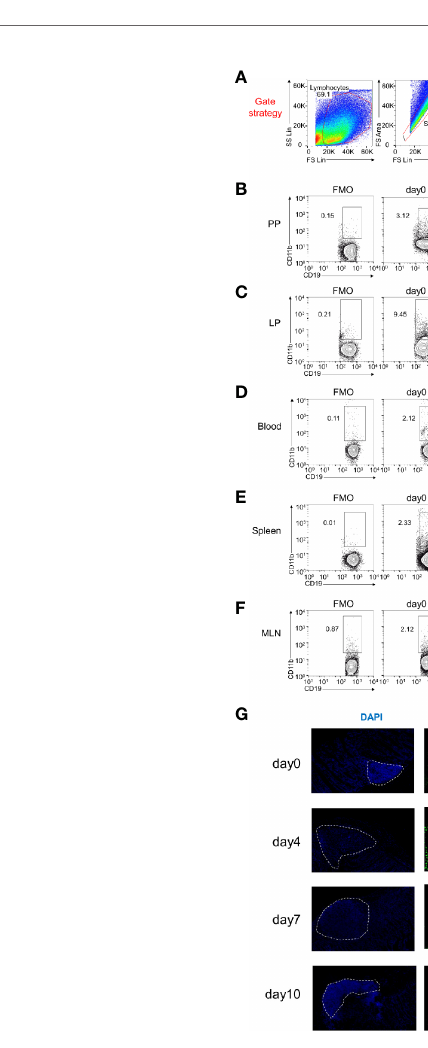
FIGURE 1 | CD11b is induced in Peyer ’ s patches (PPs) and colorectal lamina propria (LP) B cells during dextran sulfate sodium (DSS)-induced colitis. Flow cytometry was used to analyze the frequency and absolute number of CD11b + B cells. (A) Gating strategy for the identi fi cation of CD19 + CD11b + cells in gut-associated lymphoid tissue (GALT). Representative data from the LP of colitis mice on day 4 after DSS induction. Different fl uorochrome-labeled isotype control antibodies or anti-CD45, -CD19, and -CD11b antibodies were used for staining. Numbers indicate the percentage of positive cells. The right panel represents CD11b fl uorescence minus one (FMO) staining. Cells were isolated from the PPs (B) , colorectal LP (C) , total blood cell (D) , spleen (E) , and MLN (F) of DSS-induced WT mice on days 0, 4, 7, and 10. The absolute numbers were counting as follow: for PPs, colorectal LP, spleen, and MLN, the number of cells in that organ per mouse times the ratio of CD11b + B cells to obtain absolute count/mouse; for blood cell, 200ul blood cells were counted after red blood cell lysis, the number of 200ul blood cells times fi ve and times the ratio of CD11b + B cells to obtain absolute count/ml. (G) Immuno fl uorescence of CD11b + CD19 + B cells in PPs and LPs. *P < 0.05, **P < 0.01, ***P < 0.001. Data are expressed as the mean ± SEM of one experiment with six to eight mice, performed in triplicate with similar